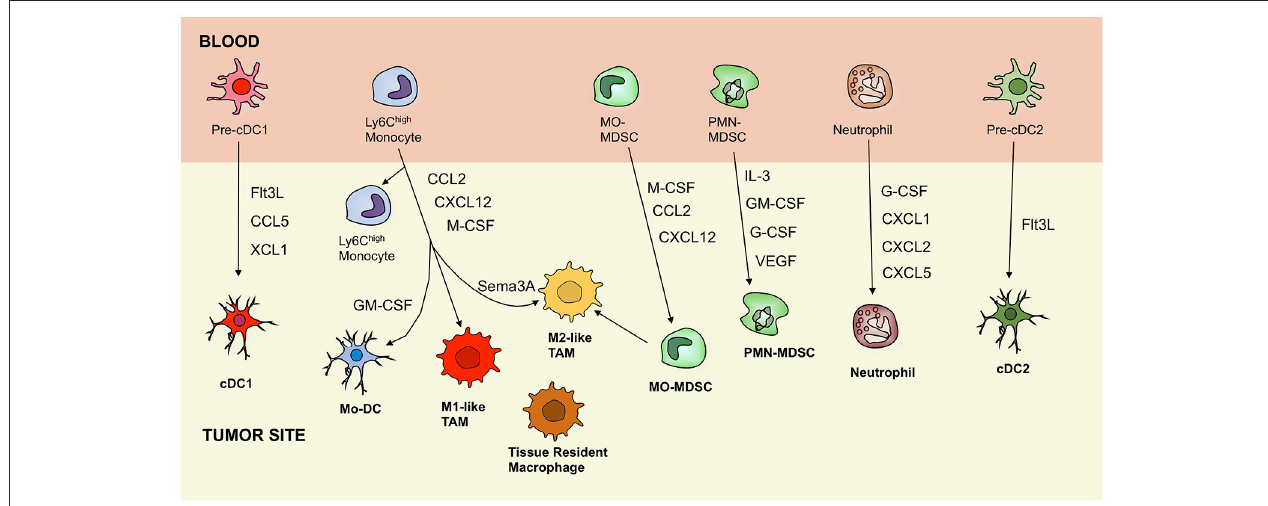
FIGURE 1 | Ontogeny of tumor-associated myeloid cells, including dendritic cells, macrophages, monocytes, myeloid-derived suppressor cells, and neutrophils. Black arrows indicate recruitment pathways that are driven by secreted factors. cDC, conventional dendritic cell; Mo-DC, monocyte-derived dendritic cell; TAM, tumor-associated macrophage; MO-MDSC, monocytic myeloid-derived suppressor cell; PMN-MDSC, polymorphonuclear myeloid-derived suppressor cell; Flt3L, Fms-related tyrosine kinase 3 ligand; CCL5, C-C motif chemokine ligand 5; XCL1, lymphotactin; GM-CSF, granulocyte-macrophage colony-stimulating factor; CXCL12, C-X-C motif chemokine 12; M-CSF, macrophage colony-stimulating factor; Sema3A, semaphorin 3A; IL-3, interleukin 3; GM-CSF, granulocyte-macrophage colony-stimulating factor; G-CSF, granulocyte colony-stimulating factor; VEGF, vascular endothelial growth factor.